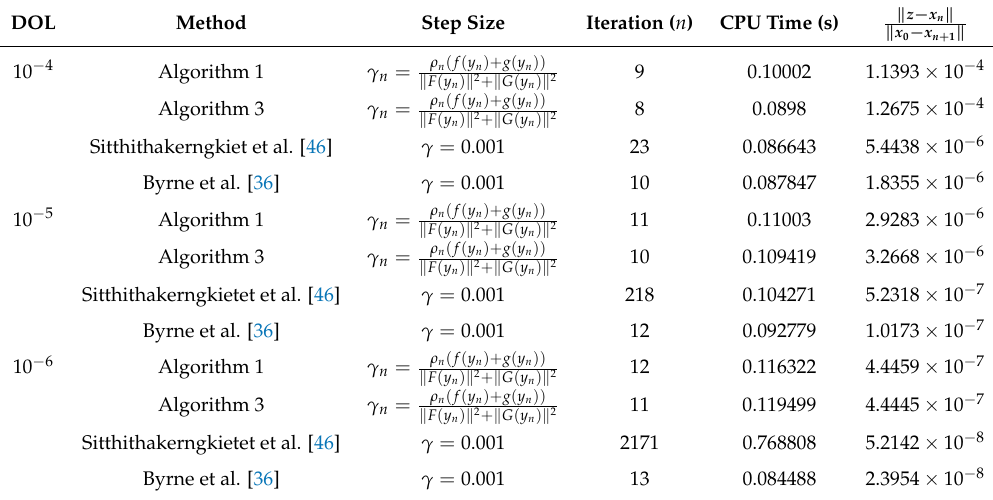
Table 3. Comparison Algorithms 1 and 3 with other